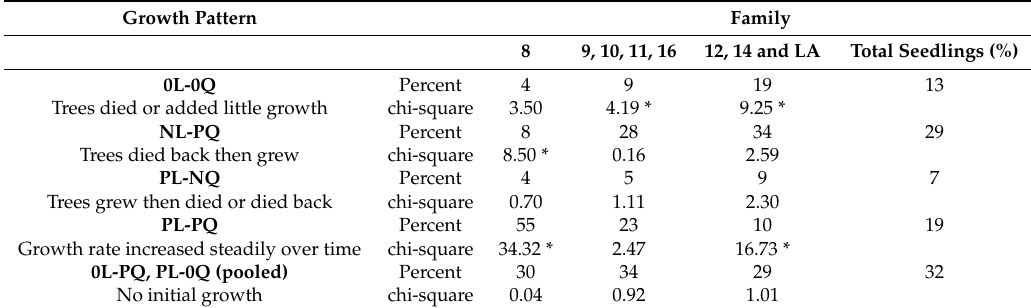
Asterisks (*) indicates the observed number within a cell differs significantly from expected. Table 5. Frequency table showing growth patterns (depicted in Figure 4) displayed by seedling size classes over the eleven-year study. LA indicates locally available seedling treatment. Small and average seedling size classes did not differ in frequency across the growth patterns and therefore were pooled. The percent of seedlings per group and chi-square value of each cell are listed. The overall chi-square value of the table is 56.95 ( p < 0.0001) with eight degrees of freedom.